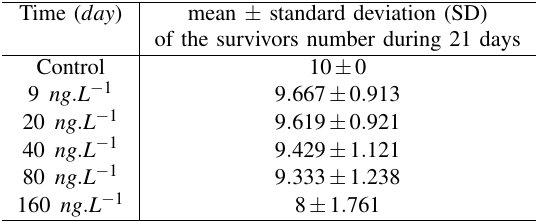
C HRONIC TEST SUMMARY TABLE (21 DAYS ) OF D ELTAMETHRIN EFFECTS SURVIVAL